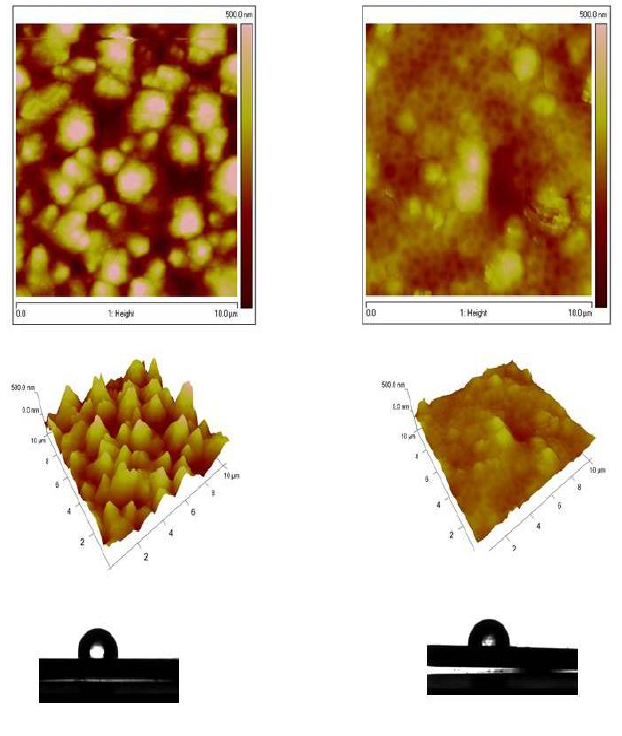
Zn-Ni (10 wt.%) Zn-Ni/TiO 2 Figure 7. AFM topography of Zn-Ni alloy and Zn-Ni/TiO 2 (System A) samples: 2D images, 3D im- ages and water contact angle.